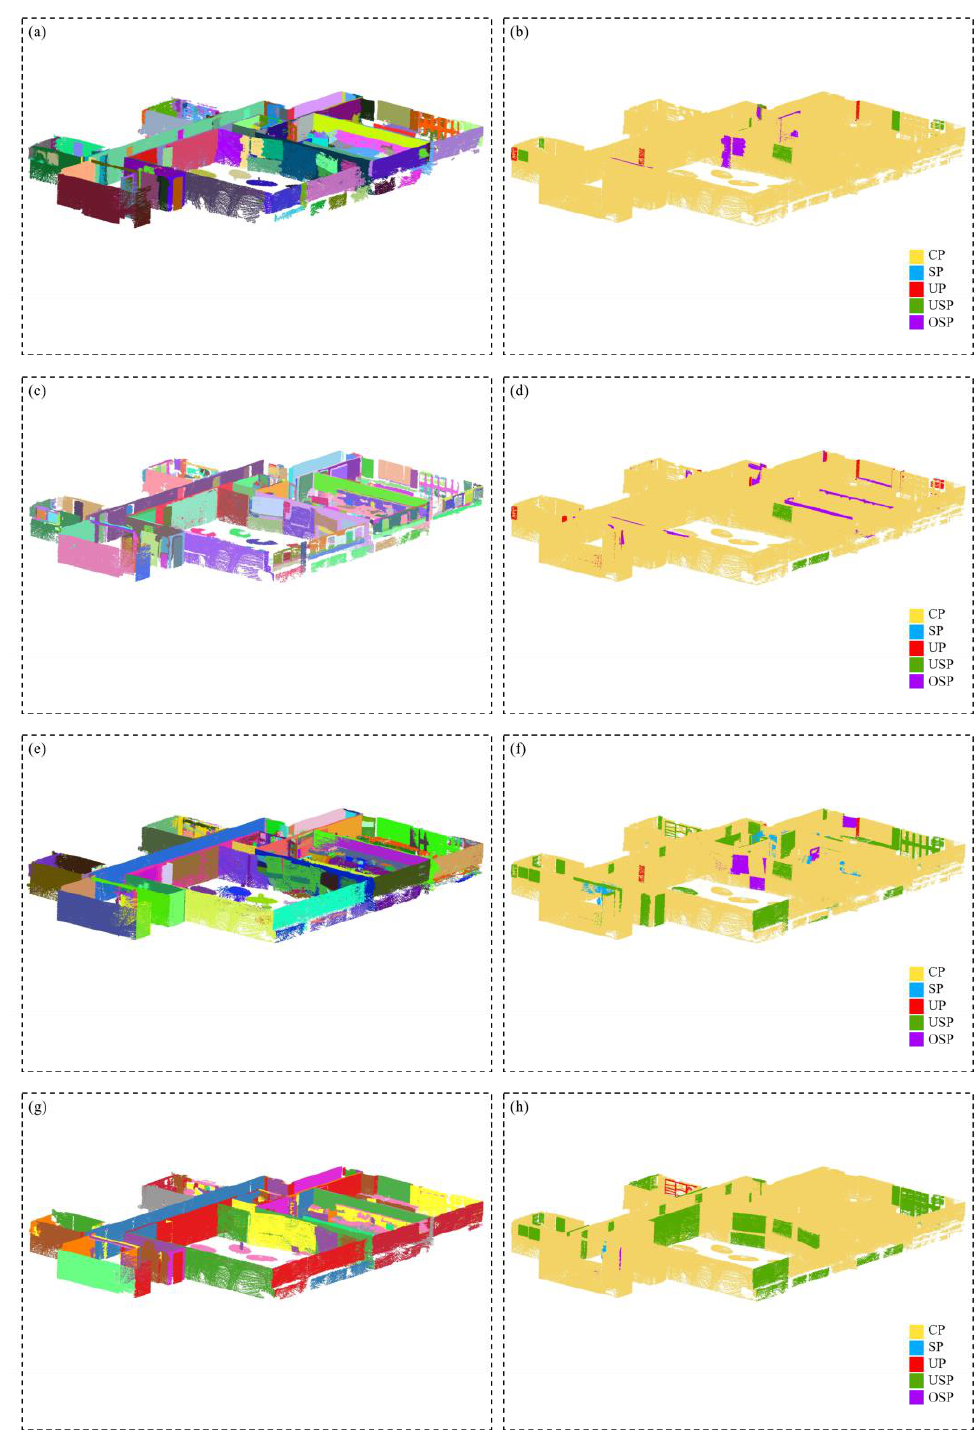
Figure 18. Comparison of plane-segmentation results for the TUB2 dataset: ( a , b ) proposed method and the main differences from ground truth, ( c , d ) RG and the main differences from ground truth, ( e , f ) efficient RANSAC and the main differences from ground truth, and ( g , h ) G-L 0 and the main differences from ground truth.